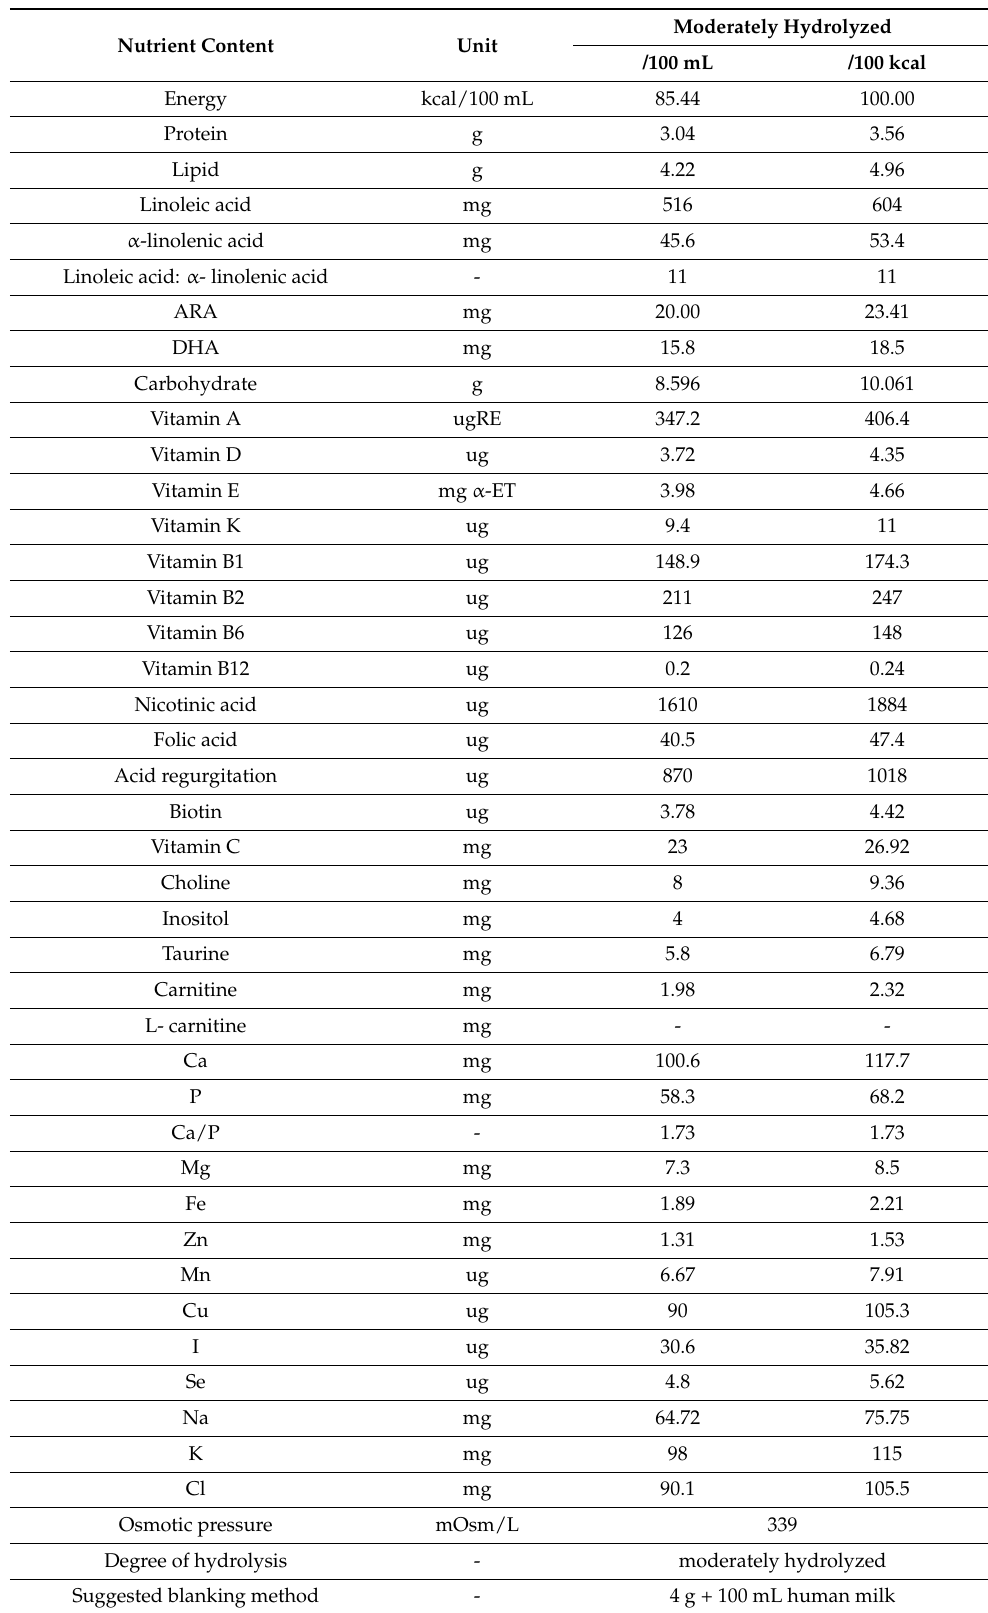
Table 1. Nutrition information of human milk fortifier in this